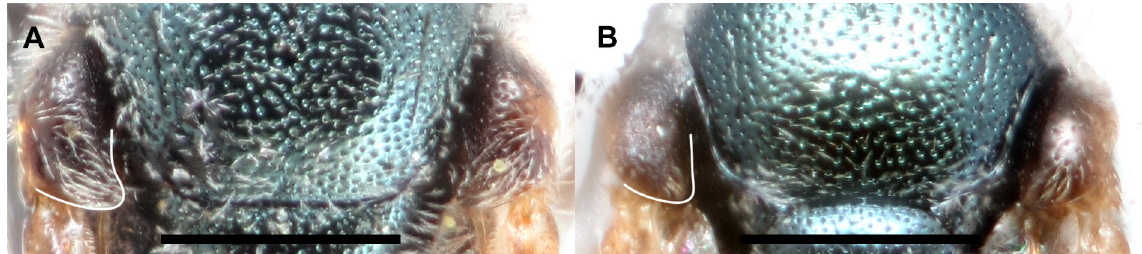
Fig. 115. Tegulae. A . Lasioglossum helianthi (Cockerell, 1916), ♂, inner posterior margin concave with distinct posterior projection (outline on left). B . L. perparvum (Ellis, 1914), ♂, inner posterior margin nearly straight without posterior projection (outline on left). Scale bars = 0.5 mm.